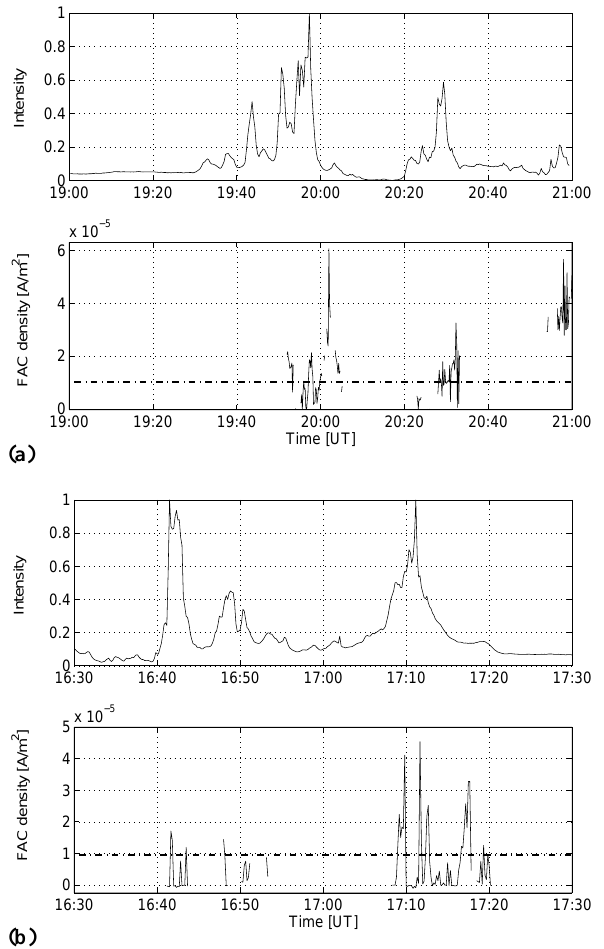
Fig. 3. The upper panel shows the normalized intensity from the ASC at Kilpisj¨arvi, Finland (a) on 5 October 1999 from 19:00 to 21:00 UT and (b) on 25 October 1999 from 16:30 to 17:30 UT with 20 seconds resolution. Regions of intense luminosity can be found for the same times as in Fig. 1. In the lower panel the field- aligned current (FAC) density estimated by formula (8) from the appendix is shown. A dash-dotted line shows a theoretical estimated threshold value of 10 − 5 A/m 2 . In (a) the strong activations exceed this value at 19:57 and 20:30 UT. The first three activations in (b) clearly reach this value. However, the last activation around 17:19 UT stays below this threshold